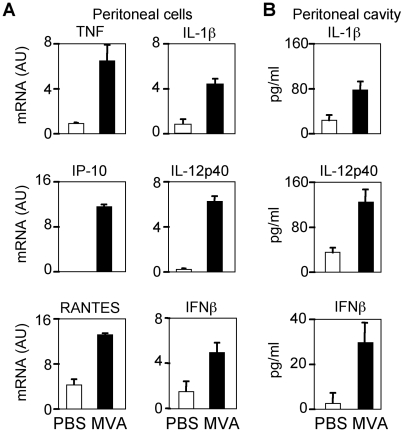
MVA stimulates cytokine, chemokine and IFNβ production in vivo.BALB/c mice were injected i.p. with MVA (107 PFU). Peritoneal cells (A) and peritoneal lavage fluid (B) were collected 12 h after infection as described in 
Materials and Methods
. TNF, IL-1β, IL-12p40, IP-10, RANTES and IFNβ mRNA contents of peritoneal cells were analyzed by RT-PCR (A). Results are expressed as the ratio of cytokines, chemokines or IFNβ mRNA levels to that of HPRT. AU: arbitrary units. Cytokine concentrations in peritoneal lavage fluid were measured by ELISA (B). Data are means±SD of triplicate samples from one experiment comprising three mice per experimental condition and are representative of two independent experiments. p<0.05 for all conditions when comparing PBS versus MVA.